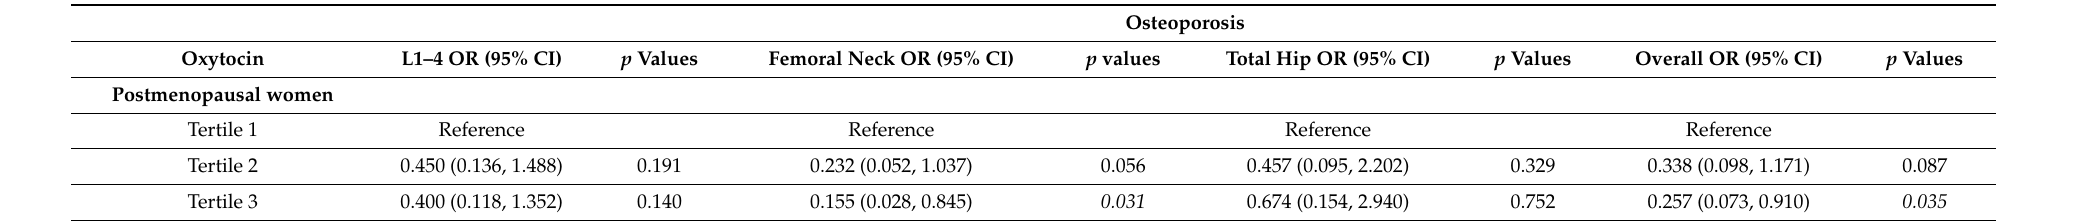
Table 4. Association between serum oxytocin level and osteoporosis in Chinese postmenopausal